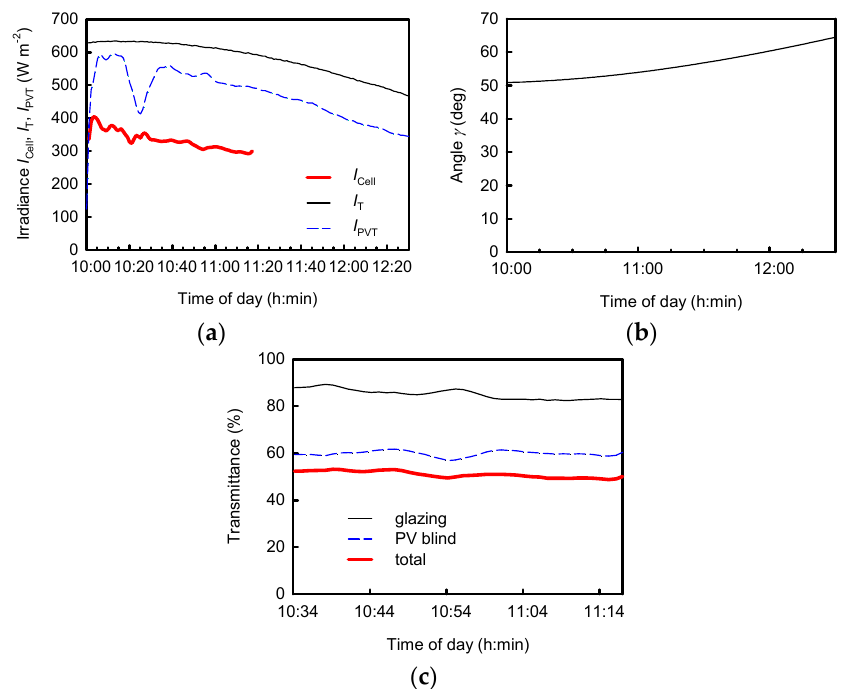
Figure 8. Sunlight transmission of the PV blind and the greenhouse glazing: ( a ) I Cell was depicted during 10:01–11:17 when the direct sunlight reached to P Cell through the 154 mm × 158 mm semi-transparent area of the PV module; ( b ) the direct beam irradiance impinged the PV blind from angle γ ; ( c ) transmittances of glazing, the PV blind, and the total of the glazing and the PV blind.